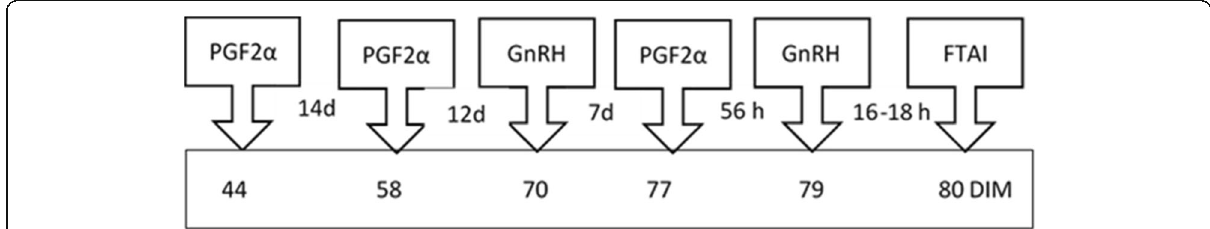
Fig. 1 Schematic representation of the Presynch-Ovsynch breeding program. (PGF2 α , prostaglandin F2 alpha; GnRH, gonadotropin releasing hormone; FTAI, fixed-time artificial insemination; DIM, days in